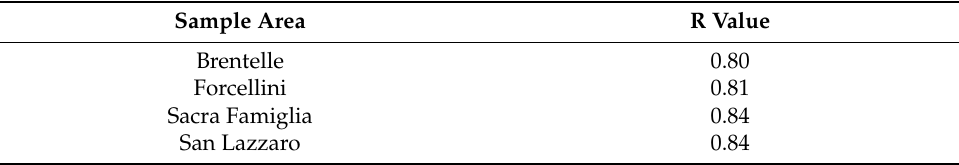
Table 3. Results of spatial linear regressions in the four sample areas.